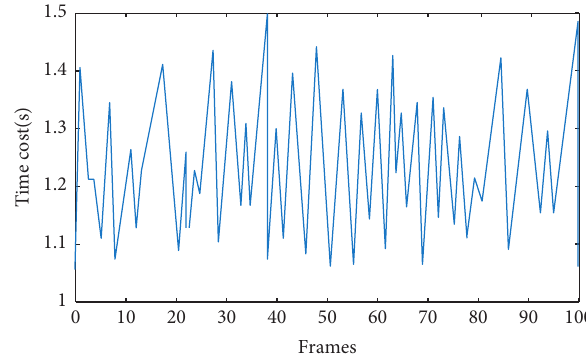
Figure 10: System running time on